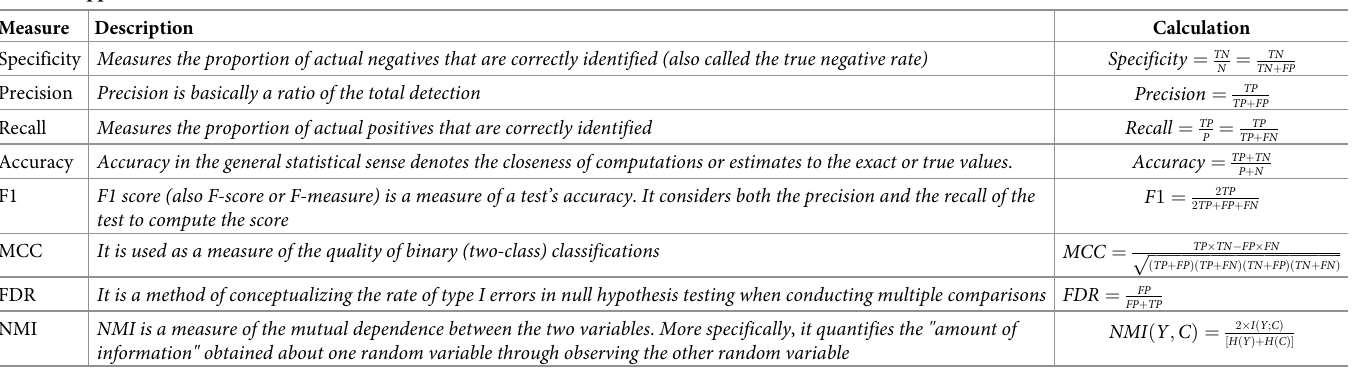
Table 1. Applied evaluation measures.